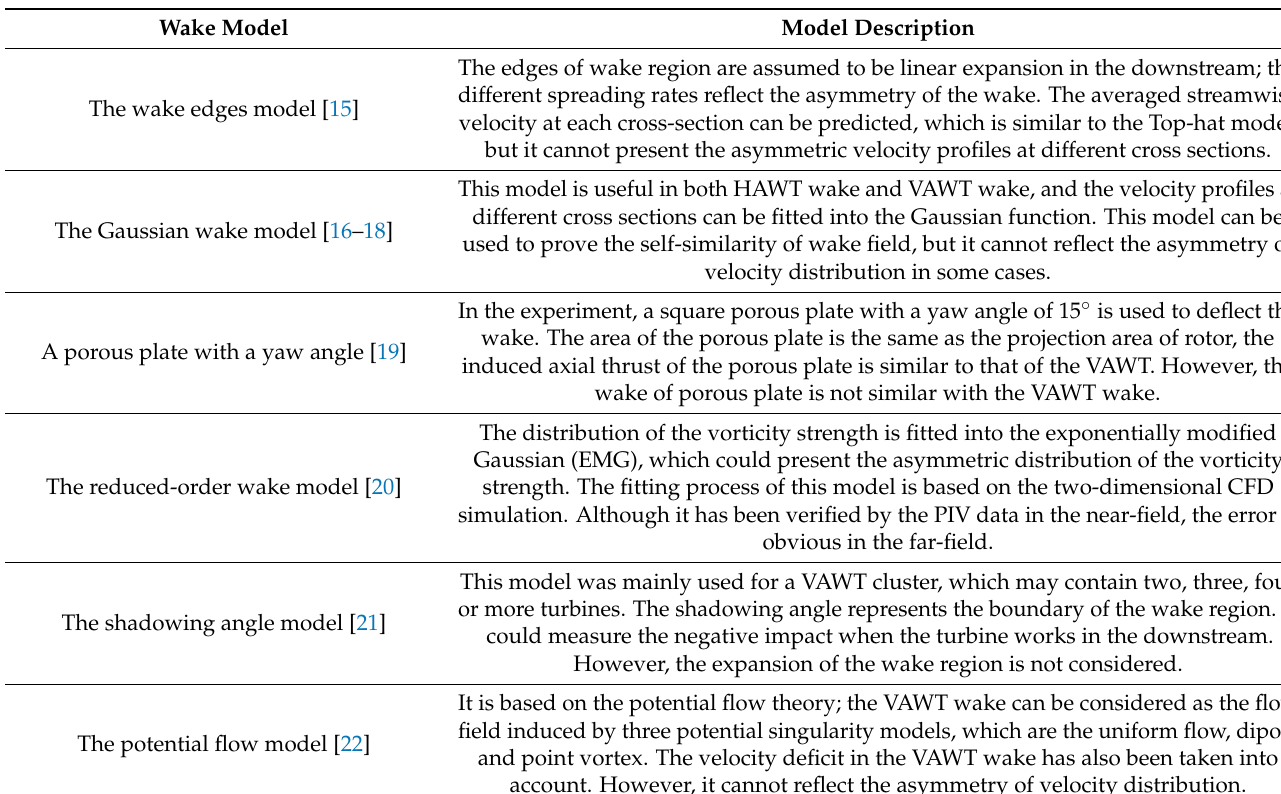
Table 1. The research status of VAWT wake